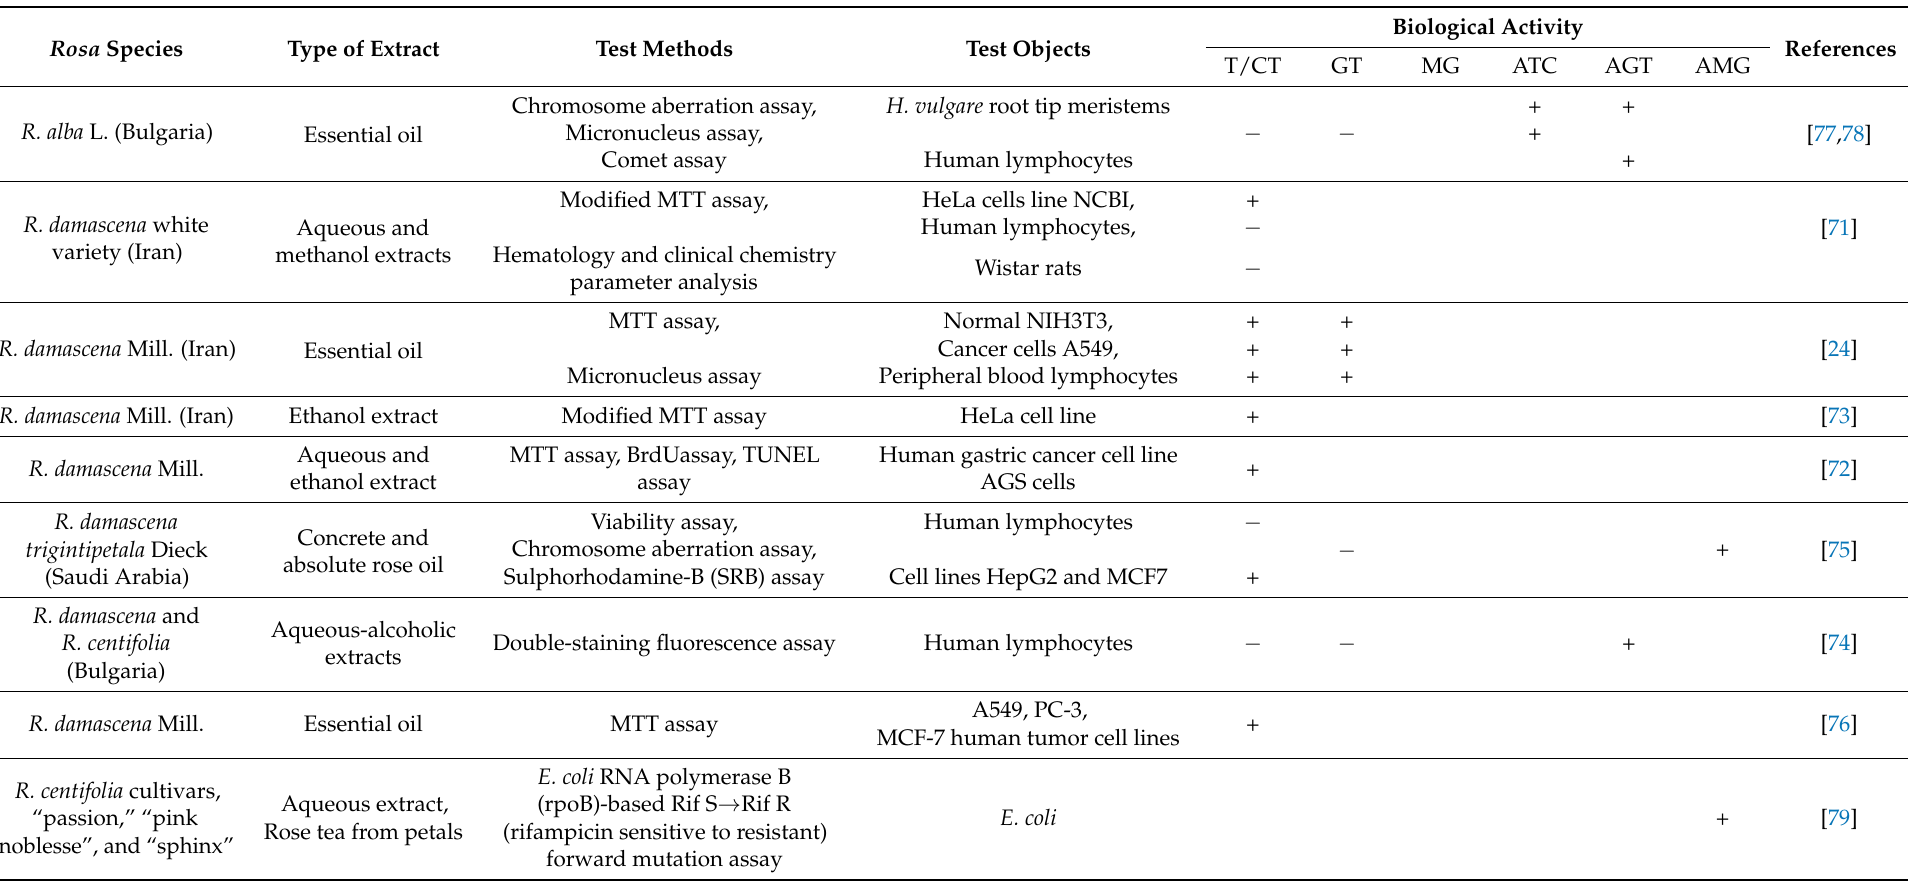
Table 2. Cytotoxic/anticytotoxic, mutagenic/antimutagenic, and genotoxic/anti-genotoxic potential of extracts and oils of the studied Rosa